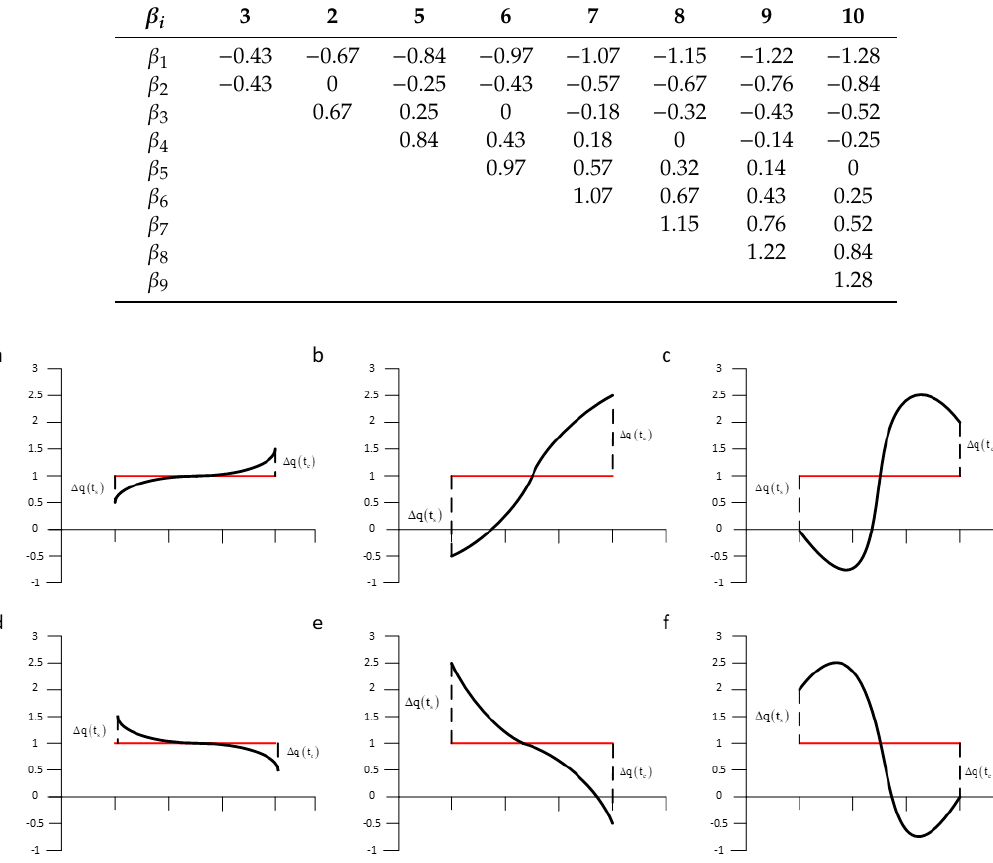
Figure 2. Several typical segments with the same average value but different trends [26]. Segment a and d , b and e , c and f are in opposite directions while all in same mean value.